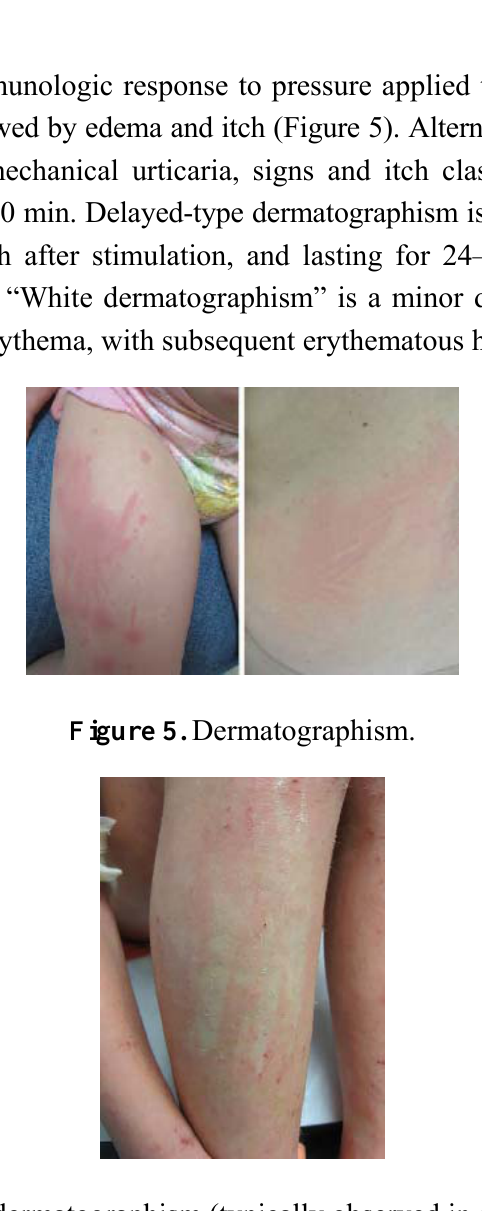
Figure 6. White dermatographism (typically observed in atopic